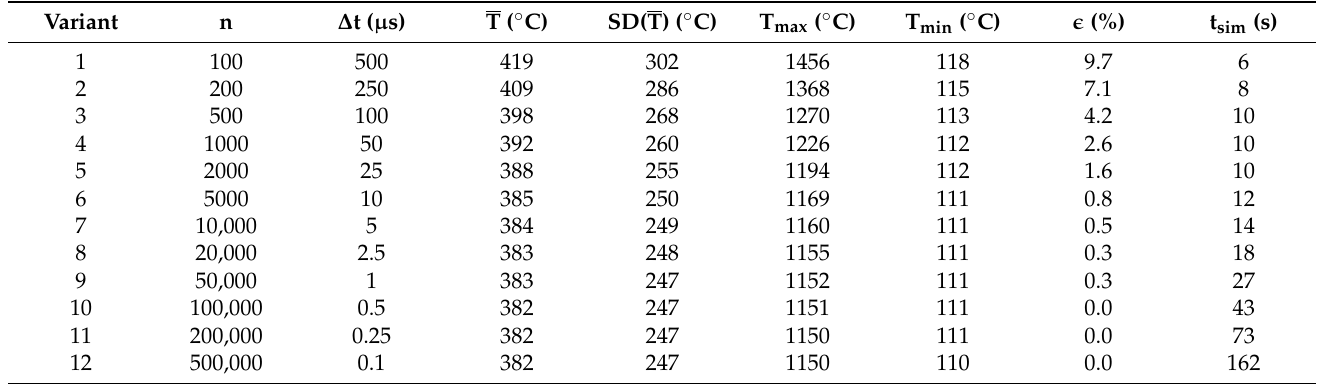
Table 4. Characterization of sheet temperature field depending on (n, ∆ t)-variants (welding time t w = 50 ms).